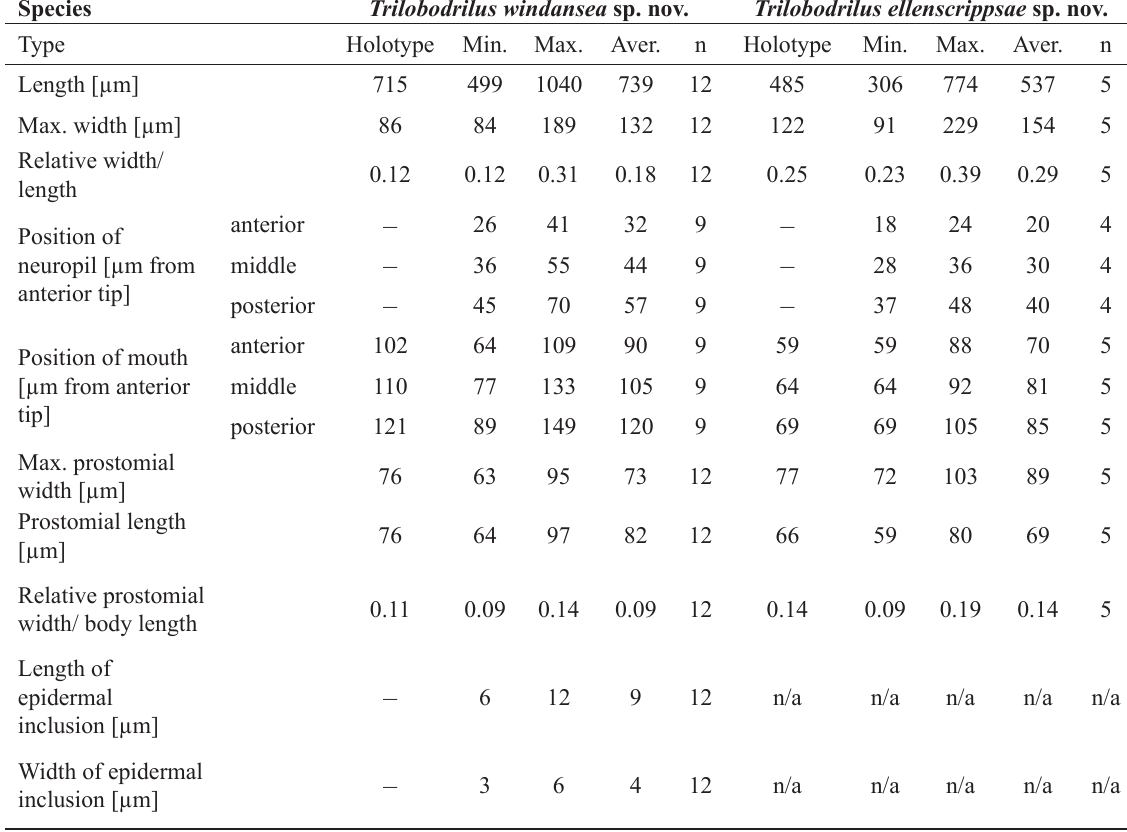
Table 1 . Measurements and morphological characters of holotype, as well as minimum, maximum and average of all measured T. windansea sp. nov. and T. ellenscrippsae sp. nov. The number of measured specimens is added to the table, all measurements are either given as µm (length or width), as distances (measured in µm from the anterior tip), or as relative measurements; “n/a” is used for